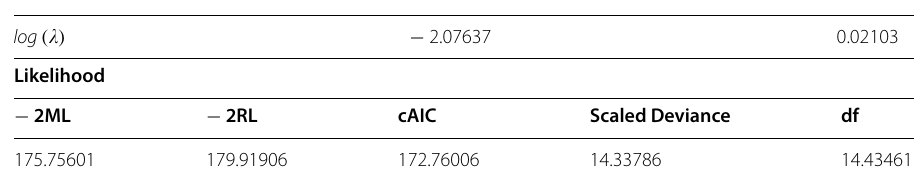
Estimates from the dispersion